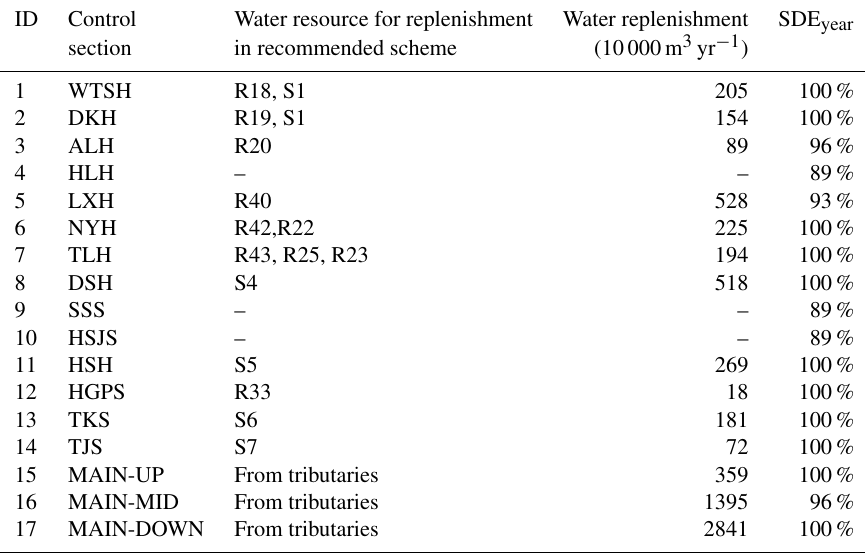
Table 5. Recommended ecological water replenishment scheme for a typical dry year ( P =